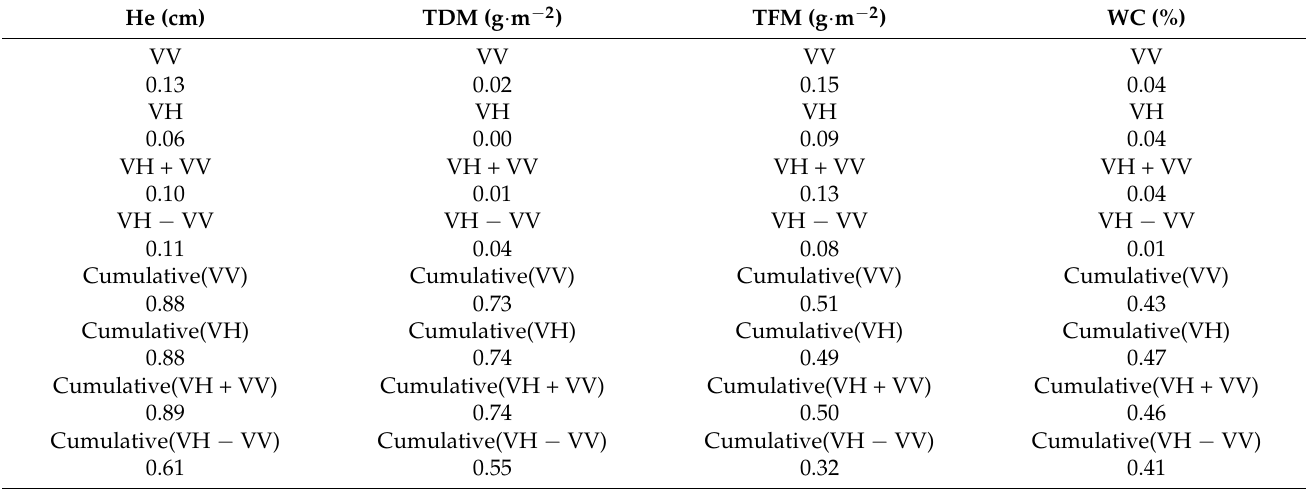
Table 4. The statistical coefficient R 2 , calculated for the different backscattering parameters (VV, VH, VH + VV, VH − VV) and their cumulative indexes, as a function of the He, TDM, TFM and WC. The number of wheat parameters used in all the following correlations is equal to n =